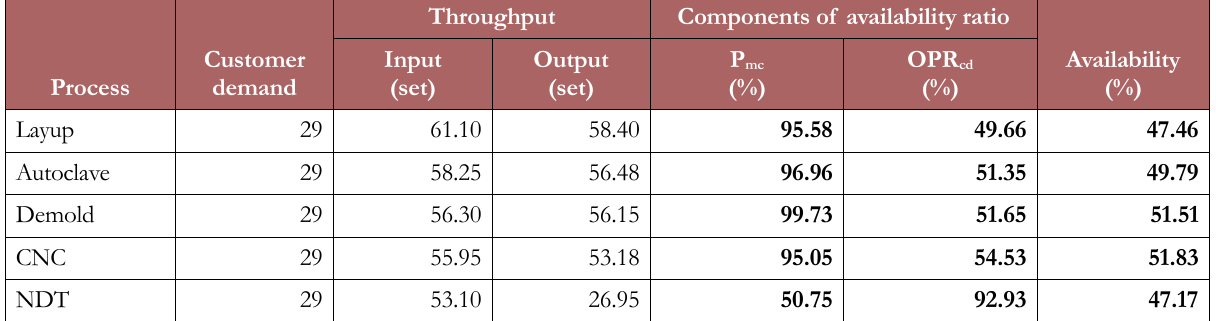
Table 8. Operational ratio and productivity of proposed availability